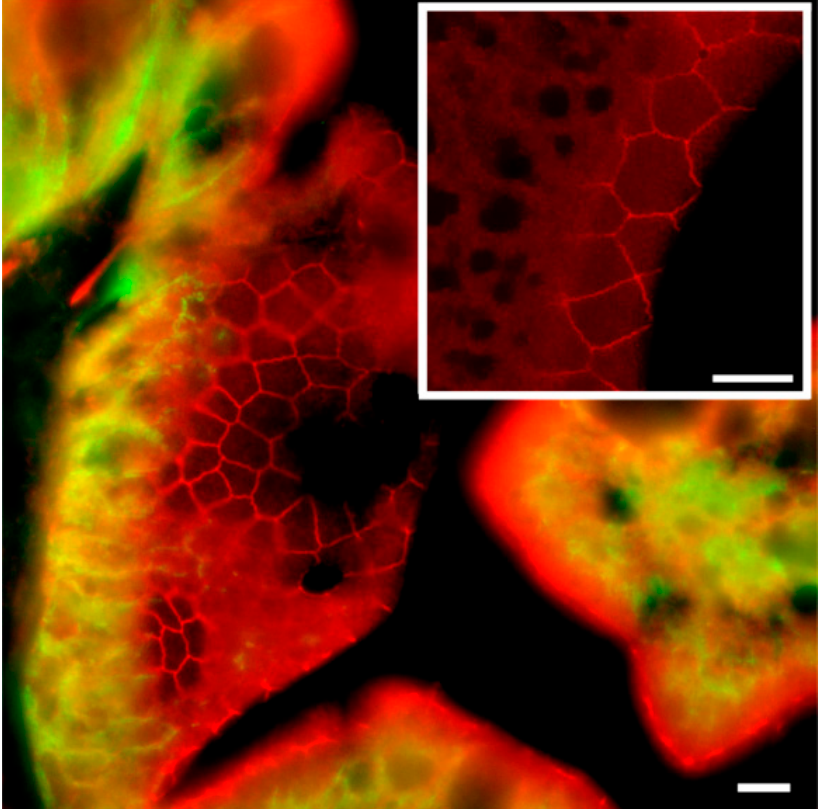
Figure 9. Confocal STED images showing the apical localization of Cldn15b (red) in SW-acclimated medaka middle intestine. Large image shows double staining with the anti-Na + ,K + -ATPase alpha subunit (green). Na + ,K + -ATPase is localized in basolateral membranes as shown in Figures 6–8, and it is absent in the apical area, where the tight junctions are located. Thus, the mosaic-like pattern of Cldn15b is without green overlay. The subfigure shows a subsection of the apical area focusing on the tight junction area. Size bars indicate 5 µ